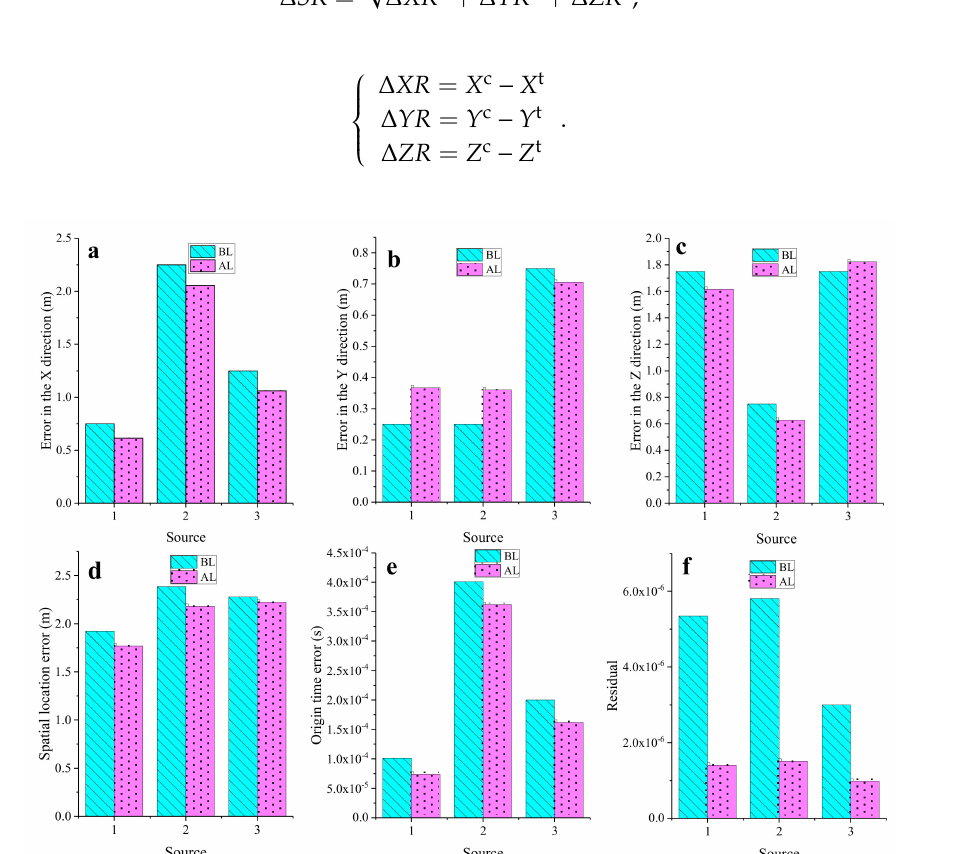
Figure 7. The location errors of AL and BL: ( a ) error in the X direction, ( b ) error in the Y direction, ( c ) error in the Z direction, ( d ) spatial location error, ( e ) origin time error, and ( f ) residual. ∆ SR represents the spatial location error. ∆ XR , ∆ YR , and ∆ ZR represent the location errors of the X, Y, and Z coordinates, respectively. X c , Y c , and Z c represent the location results of the X, Y, and Z coordinates, respectively. X t , Z t , and Z t represent the theoretical values of the X, Y, and Z coordinates,